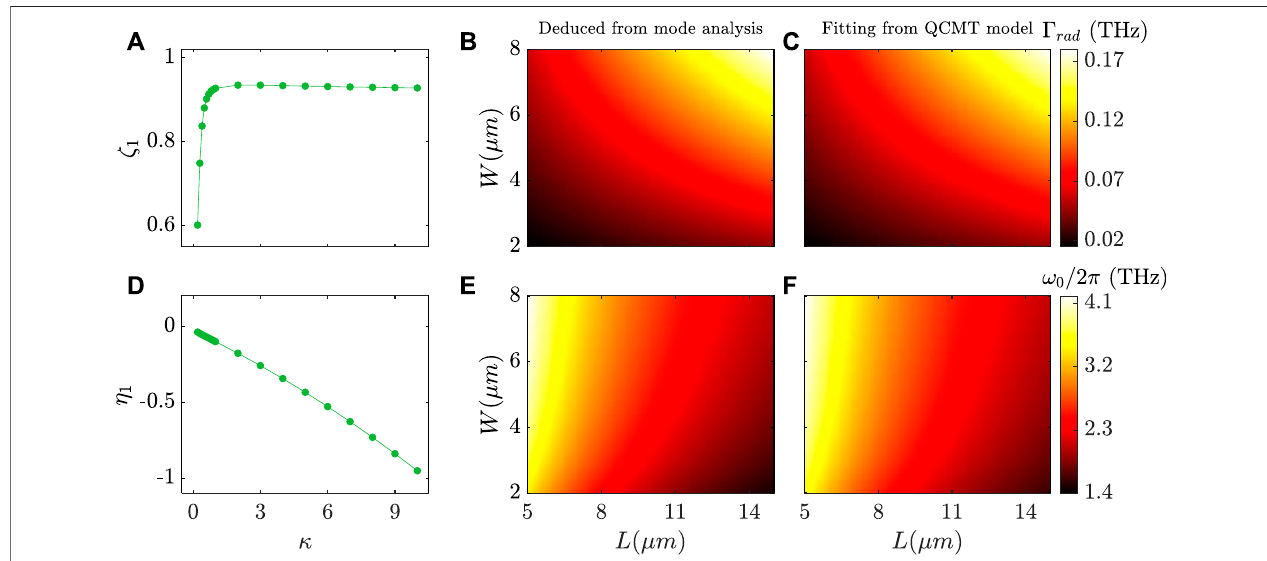
FIGURE 3 | Validations of Γ rad and ω 0 calculated from the QCMT model. (A,D) ζ 1 (A) and η 1 (D) obtained from mode analysis. The green solid lines are guides for eyes (B,C) Γ rad as a function of L and W calculated from Eq. 11 (B) and fi tted from QCMT model (C) . (E,F) ω 0 as a function of L and W calculated from Eq. 10 (E) and fi tted from QCMT model (F) .